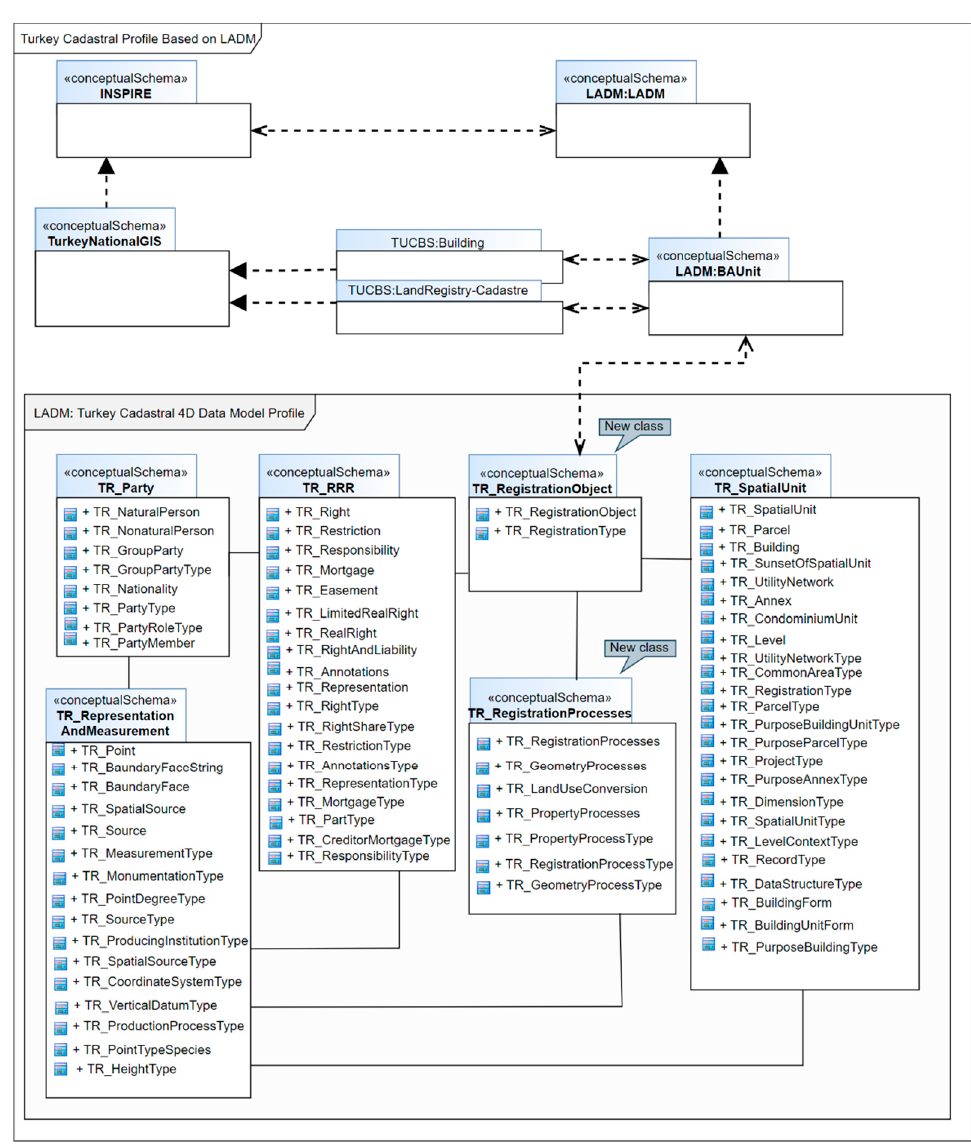
Figure 3. Shows the general framework for modelling the legal part of the proposed integrated model based on LADM.